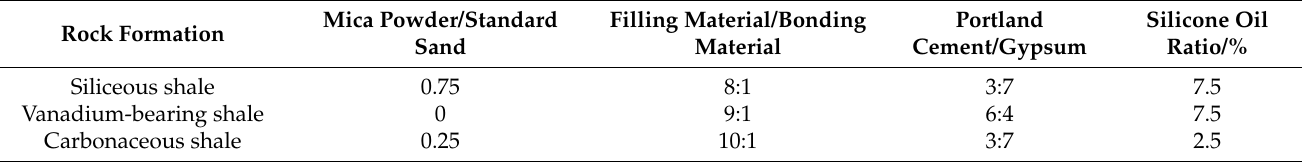
Table 10. Proportioning scheme of similar material.